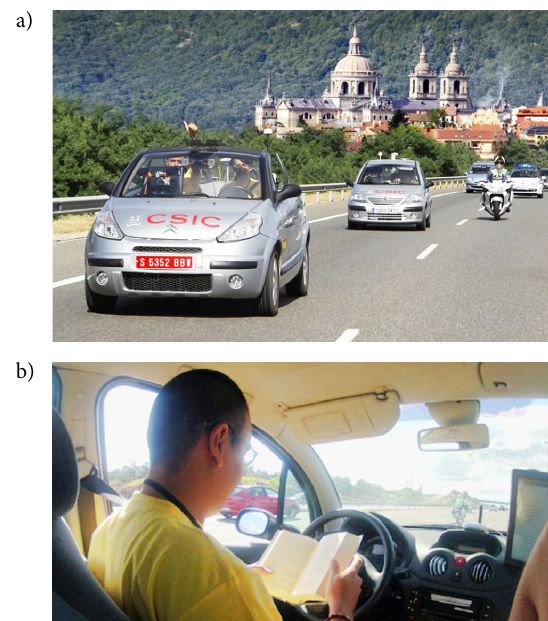
Fig. 9. Demonstration on the motorway: a – Clavileño and Platero during the experiment; b – inside the trailing vehicle, showing the ‘driver’ reading a book